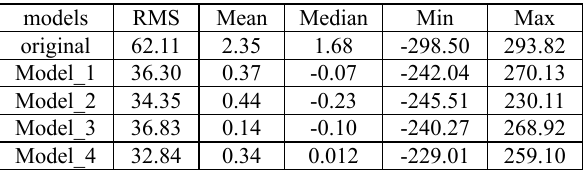
Table 2. Crossover adjustment results from the four models.